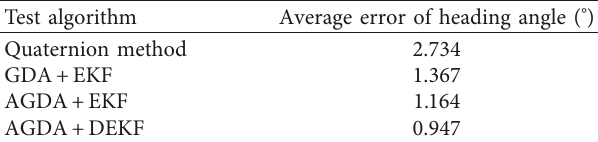
Table 4: Average error of heading angle in test 2. Test algorithm Average error of heading angle ( °